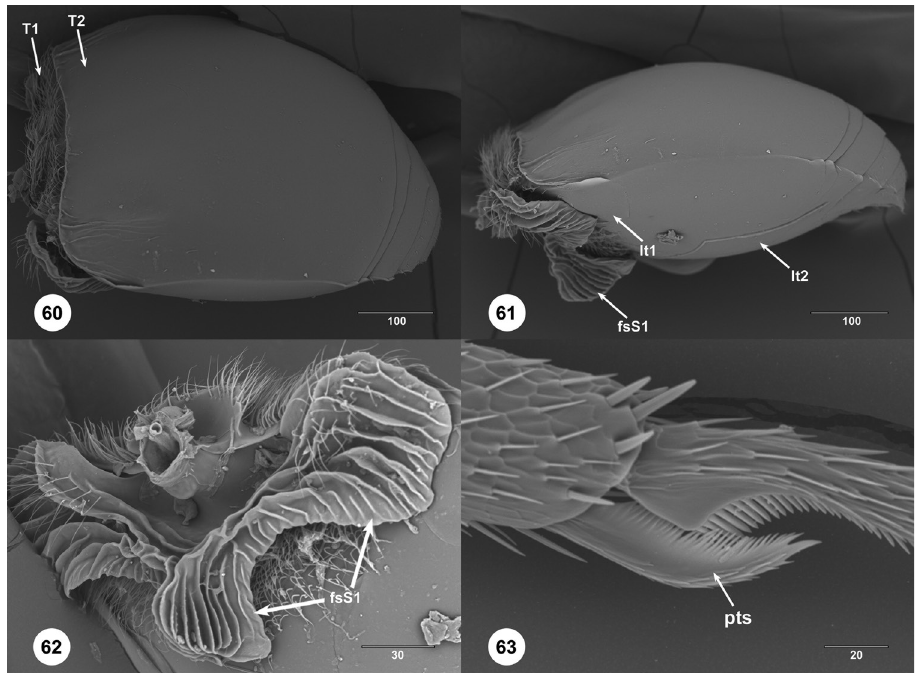
sions: present. Setation of pronotal cervical sulcus: absent. Setation of cervical pronotal area: absent. Sculpture of pronotal shoulders: reticulate. Sculpture of anterior margin of pronotal shoulders: carinate. Posterolateral margin of pronotal shoulders: sharply angled. Posterior margin of pronotal shoulders: rounded. Antero-admedian line: pre- sent. Anterior admedian depression or pit: present. Parapsidial line: absent.